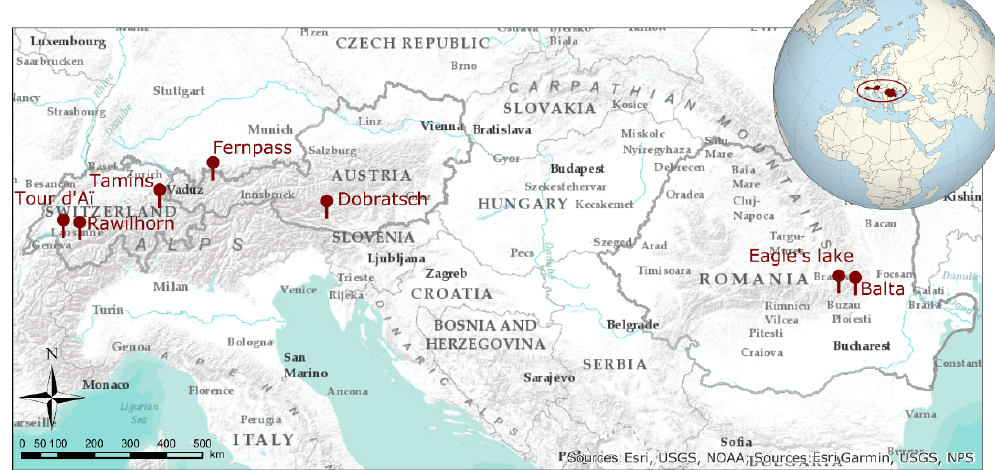
Figure 1. Geographical locations in Europe of the Tamins, Tour d’Aï, and Rawilhorn rockslides (Switzerland); the Fernpass and Dobratsch rockslides (Austria); and the Eagle’s Lake and Balta rockslides